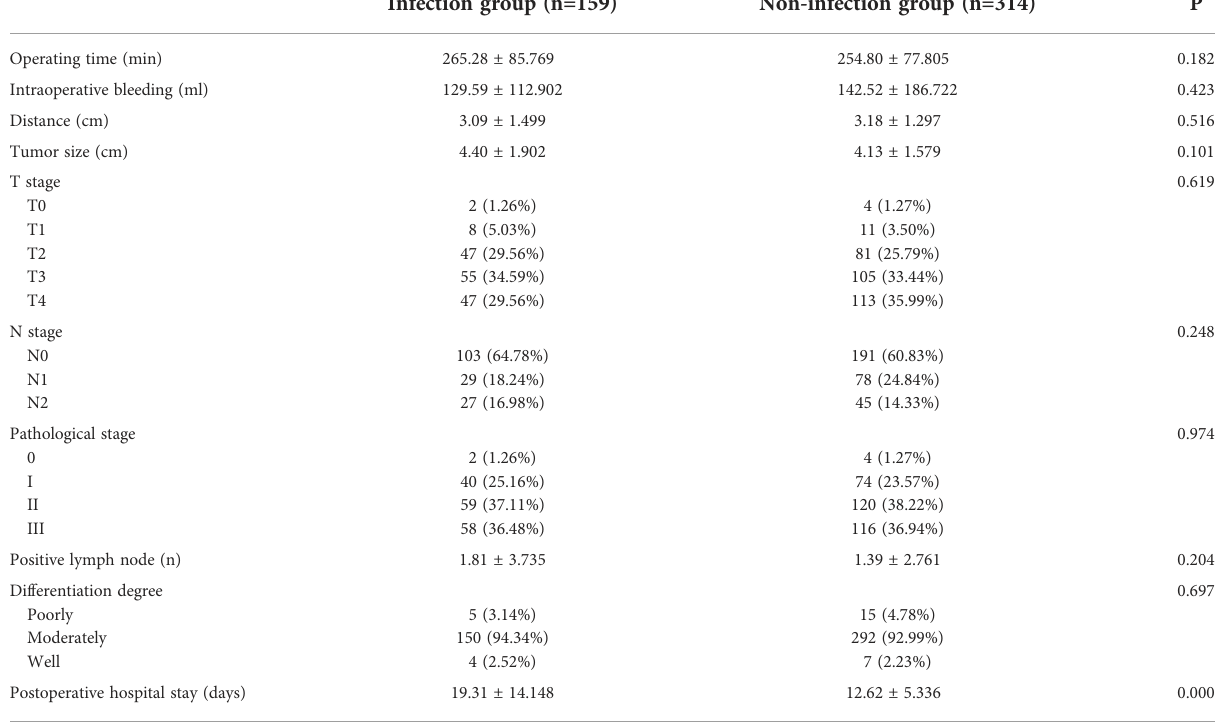
TABLE 2 Surgical conditions and postoperative pathological features.